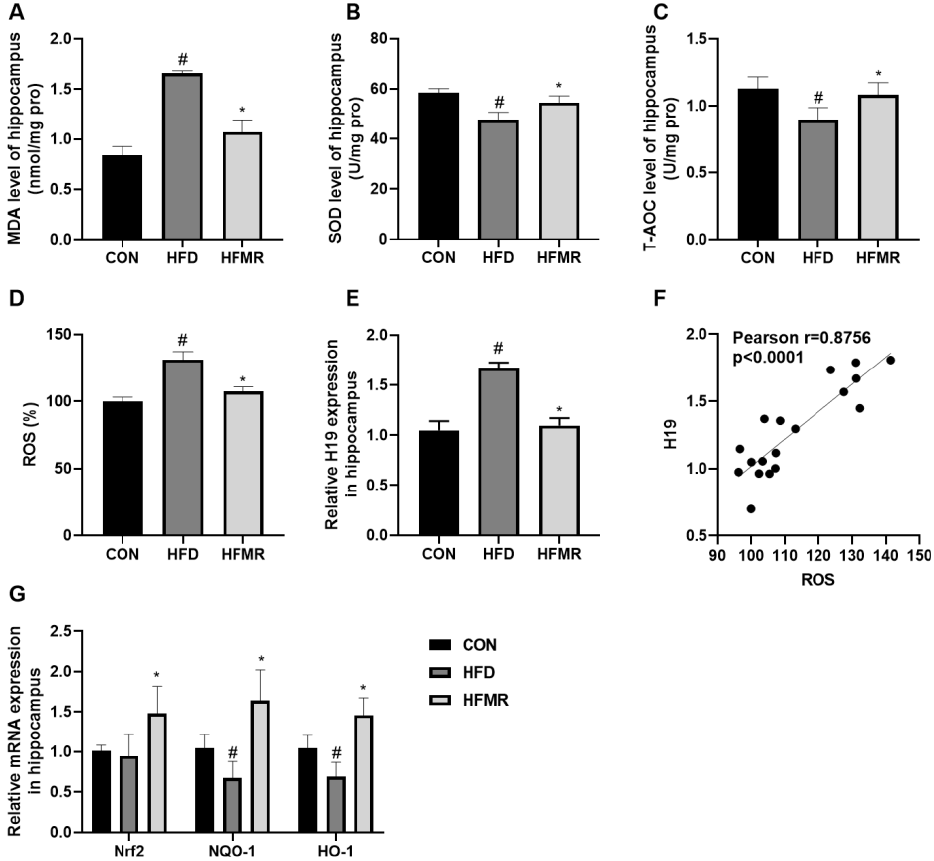
Figure 3. Effects of MR on hippocampal oxidative stress and H19 expression in HFD-induced insulin-resistant mice. ( A ) MDA level of the hippocampus. ( B ) SOD level of the hippocampus. ( C ) T-AOC level of the hippocampus. ( D ) Relative ROS level of the hippocampus. ( E ) Relative H19 expression in the hippocampus. ( F ) Pearson correlation coefficient between ROS and H19. ( G ) Nrf2 signaling pathway-related mRNA expression. All data are shown as the mean ± SEM (n = 8). # p < 0.05 (HFD versus CON); * p < 0.05 (HFMR versus HFD).